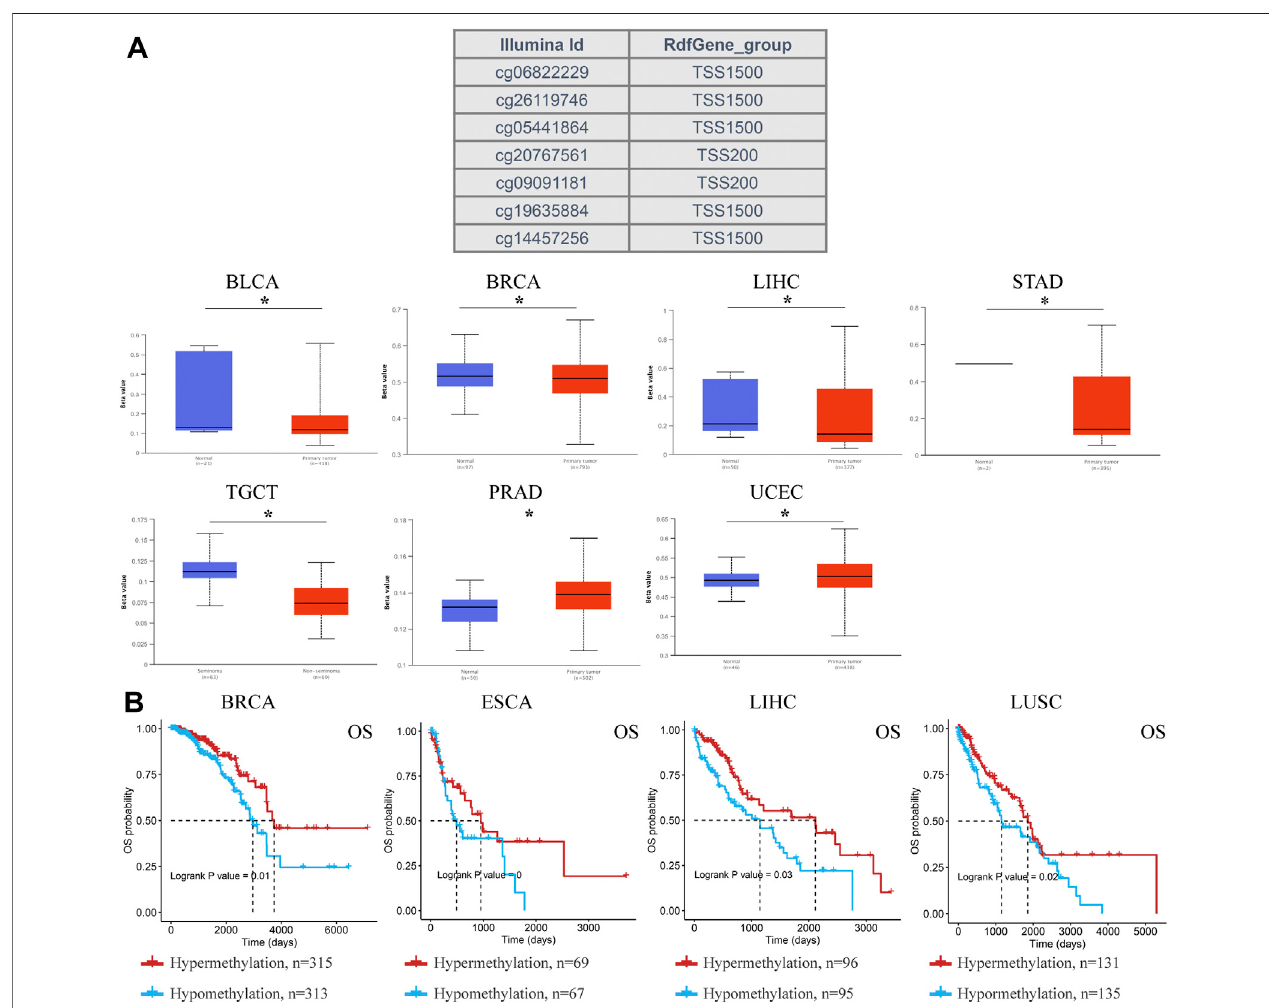
FIGURE6| DNAmethylationaberrationofACSL4indifferentcancersfromtheUACLANandGSCAdatabase. (A) .ProbesfordetectingDNAmethylationofACSL4 promoter and ACSL4promotermethylation pro fi le in different cancers.ACSL4hypomethylated inBLCA, BRCA, LIHC, STAD and TCGT, while higher methylation levels inPRADandUCECfromUACLANdatabase(* p < 0.05).TheBetavalueindicateslevelofDNAmethylationrangingfrom0(unmethylated) to1(fullymethylated).Different beta value cut-off has been considered to indicate hyper-methylation (Beta value: 0.7 – 0.5) or hypo-methylation (Beta-value: 0.3 – 0.25). BLCA (bladder urothelial carcinoma); BRCA (breast invasive carcinoma); LIHC (liver hepatocellular carcinoma); STAD (stomach adenocarcinoma); TGCT (testicular germ cell tumors); PRAD (prostate adenocarcinoma); UCEC (uterine corpus endometrial carcinoma). (B) . Correlation between ACSL4 DNA hypomethylation and prognosis in different